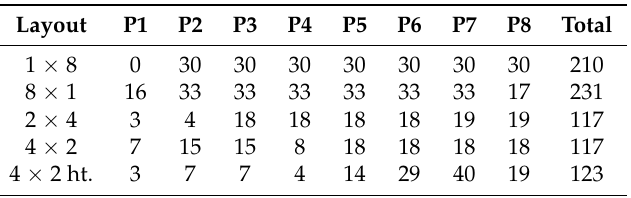
Table 2. Number of CTUs with their encoding modified, for the partitioning of a Full HD frame into 8